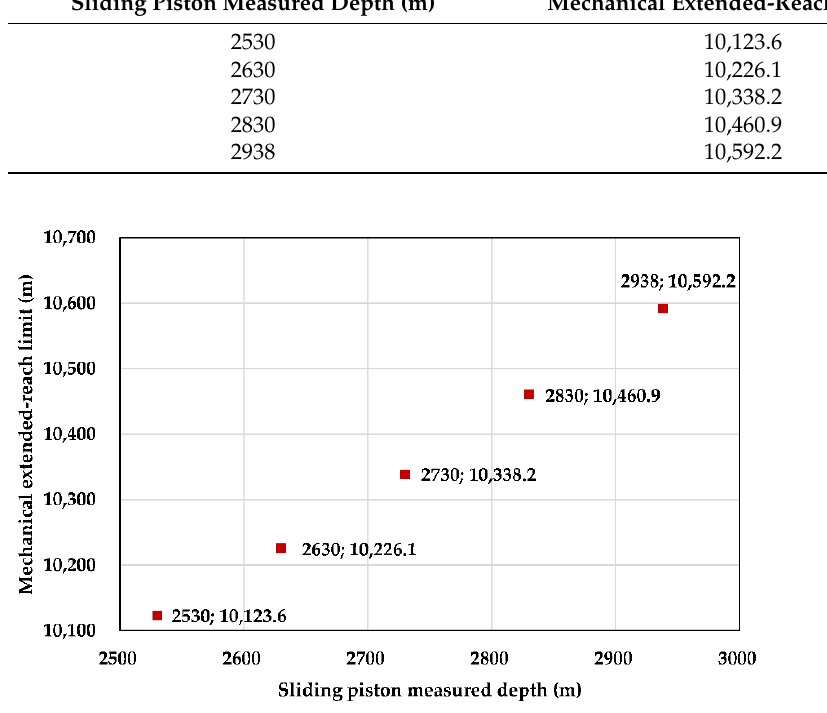
Figure 8. Effect of the sliding piston measured depth on the mechanical extended-reach limit. Table 7. Mechanical extended-reach limits with different outer diameters of the outer pipe.